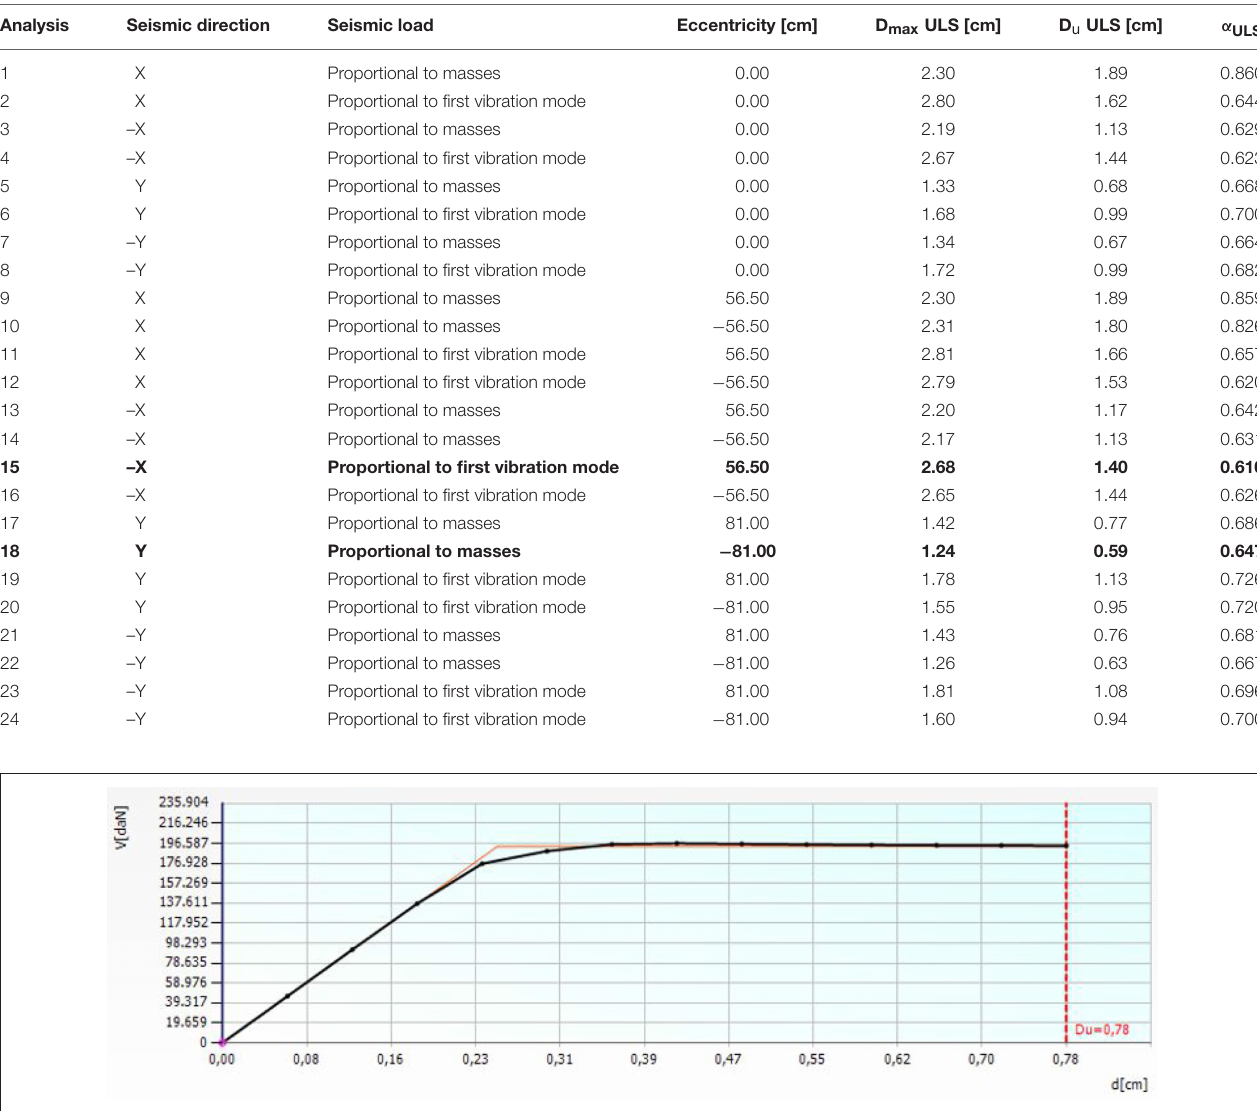
TABLE 1 | Pushover analysis results on the URM building. Analysis